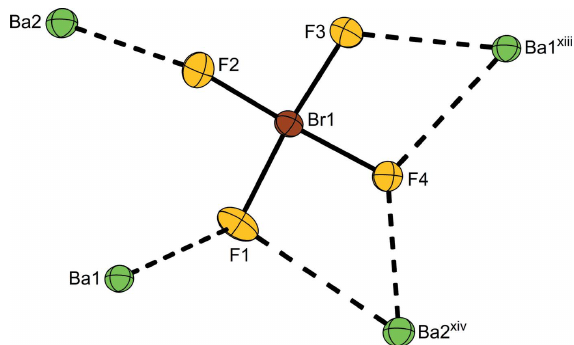
Figure 1 The closest contacts between one [BrF 4 ] (cid:2) anion and surrounding Ba 2+ cations. Displacement ellipsoids are shown at the 50% probability level. [Symmetry codes: (xiii) x + 1